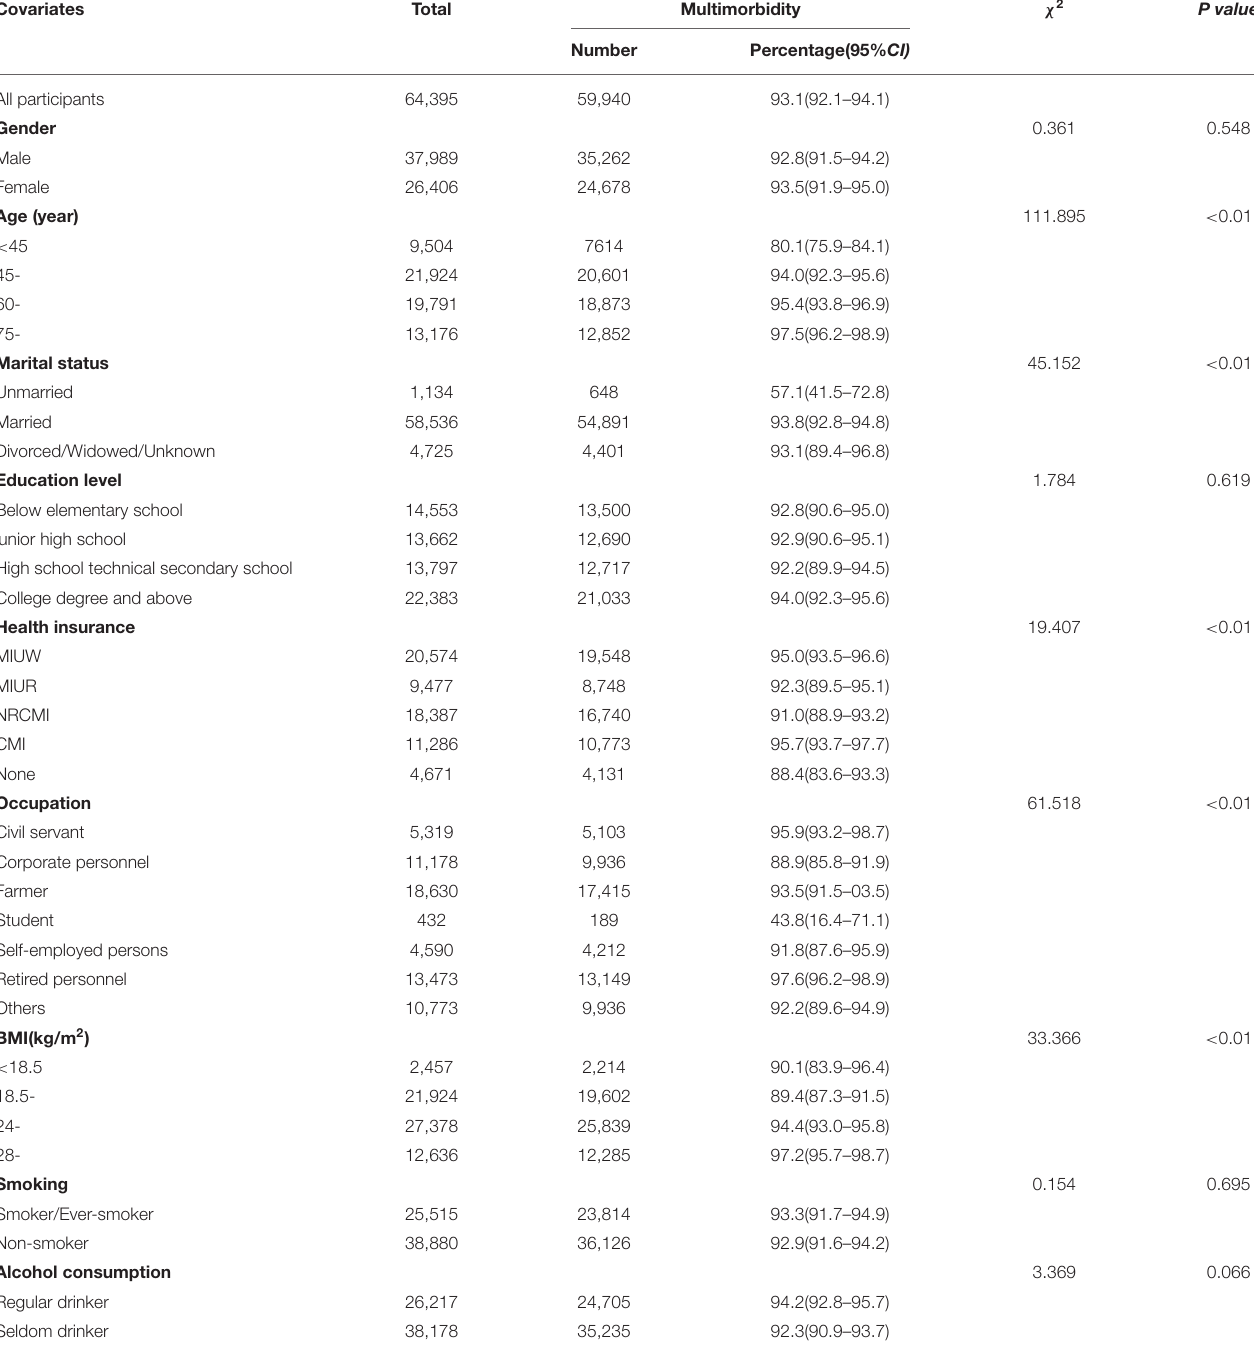
TABLE 1 | Socio-demographic, BMI, lifestyle and multimorbidity characteristics of all study participants. Covariates Total